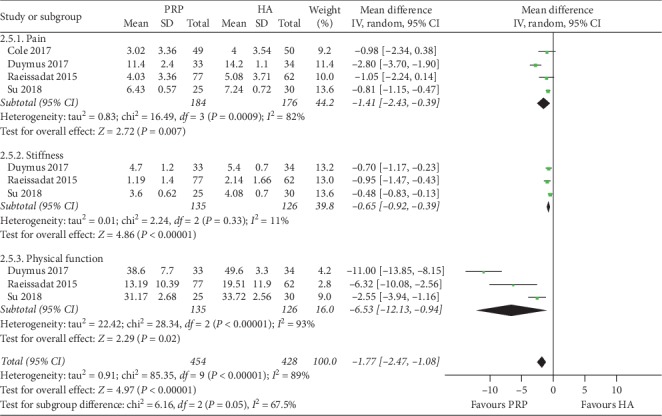
Forest plots showing the comparison of the effects of PRP and HA on WOMAC scores at 12th months of follow-up in overweight patients with knee OA.